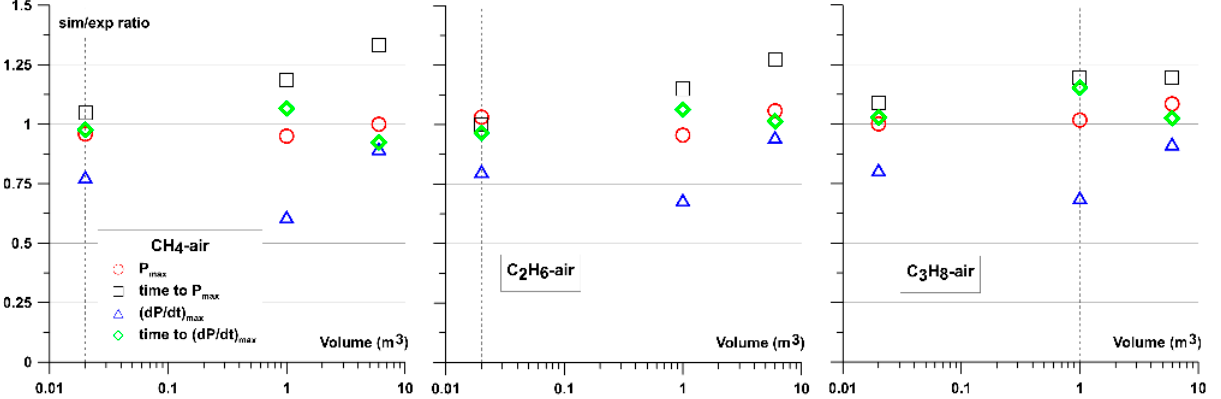
Figure 19. Ratios of simulated (non-adiabatic) and experimental parameters for all considered mixtures.